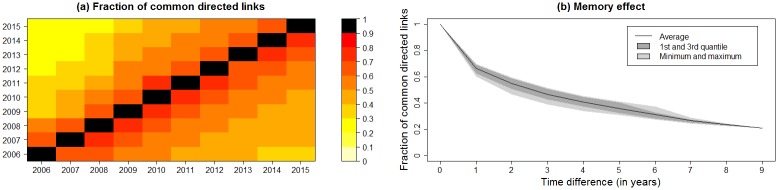
Fraction of common directed links.(a) Network loyalty (fraction of common directed links contained in two consecutive snapshots) of the pig movement network in Denmark between 1st January 2006 and 31st December 2015. Asymmetry is caused by varying number of directed links per year. (b) Development of the fraction of common directed links per year time difference. Dark grey areas represent the interval between 1st and 3rd quantile, light grey areas represent the interval between minimum and maximum values for the fraction of common directed links.